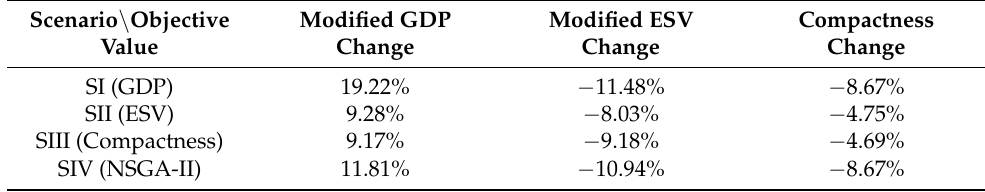
Table 4. The objective values, under different scenarios, described in the main text.